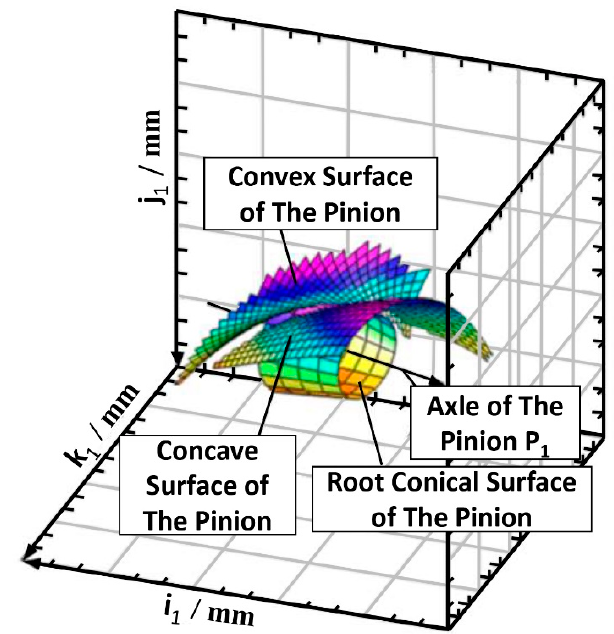
Figure 4. Theoretical Modeling of the pinion concave and convex surfaces.